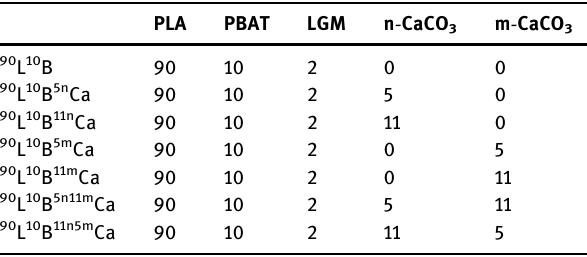
Table 2: The composite formulations of PLA/PBAT/CaCO